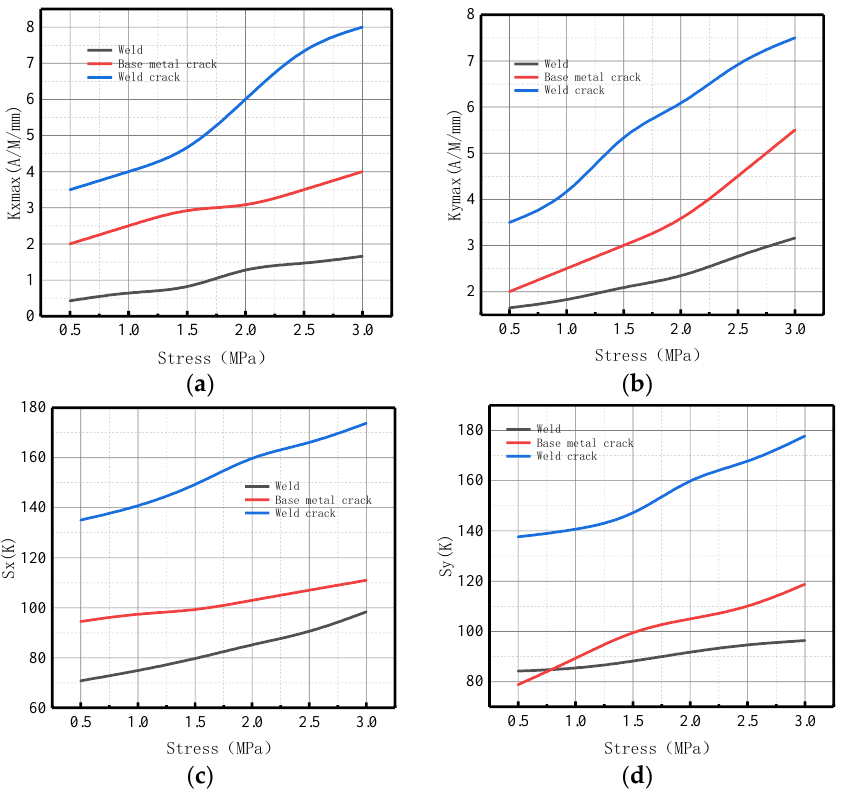
Figure 40. Variations of Kmax and S ( K ) parameters calculated by experiment under three conditions. ( a ) Axial component of Kmax ; ( b ) radial component of Kmax . ( c ) Axial component of S ( k ); ( d ) radial component of S ( k ).